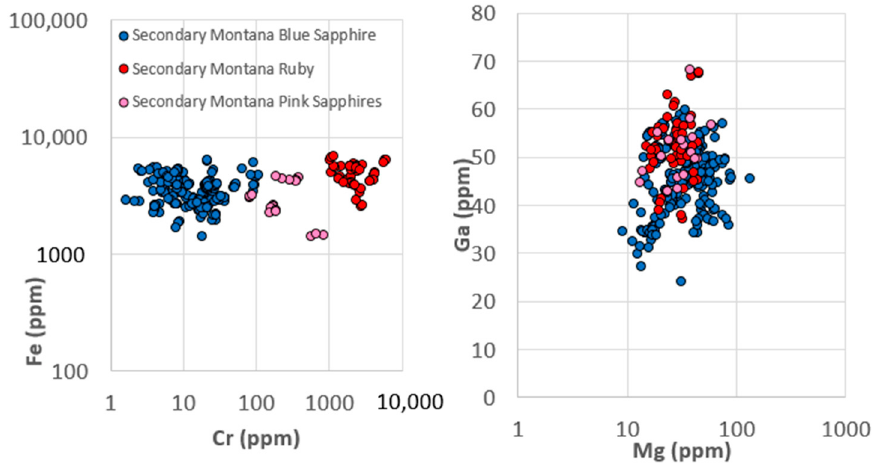
1 Table 9. Correlation table for trace elements of only blue/green and pink sapphires from the secondary Montana sapphire mines. Mg Ti